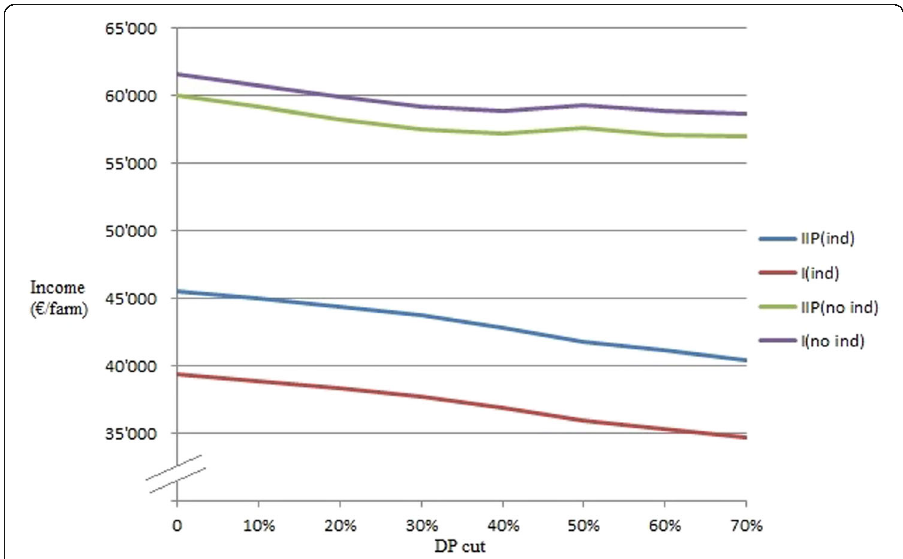
Fig. 3 Average farm income level of farms experiencing a severe drop of income (ind) and the other farms (no ind), with and without IST in place (IIP and I) and for different reductions of direct payments level. Average of the period 2012 – 2015 (Euro/farm). Source: Own elaborations on Italian FADN